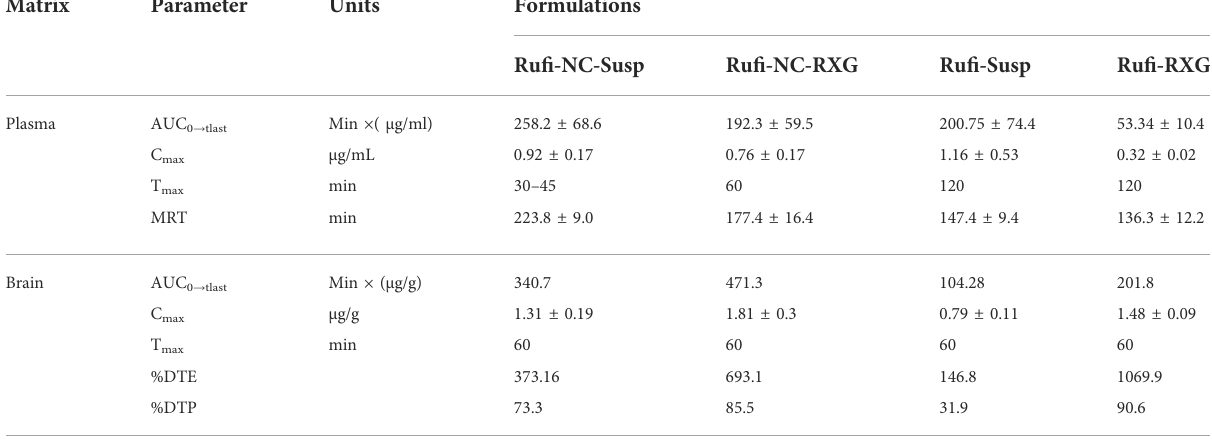
TABLE 4 Pharmacokinetic parameters of Ru fi -NC-RXG, Ru fi -NC-Susp, Ru fi -Susp, and Ru fi -RXG in brain and plasma following intranasal administration at a drug dose of 1 mg/kg in male Wistrar rats.